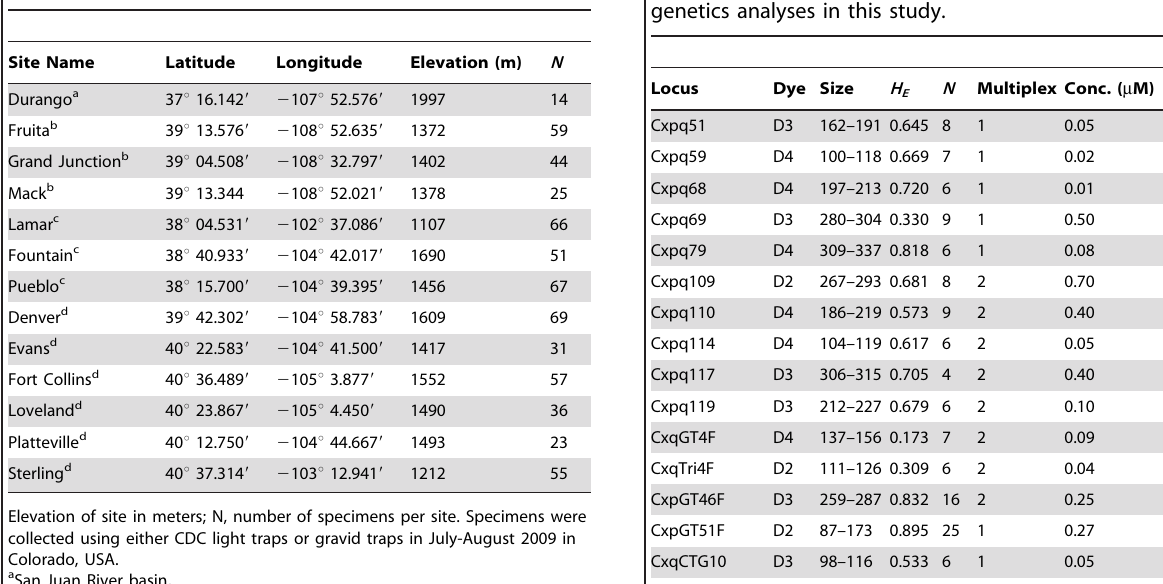
Table 2. Microsatellite loci used or screened for population genetics analyses in this study.